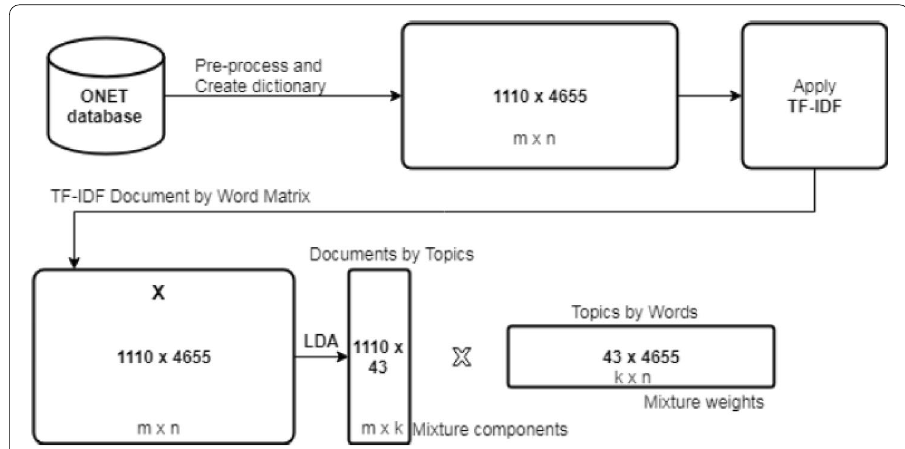
Fig. 1 Schematic diagram of the applied Latent Dirichlet Allocation (LDA)